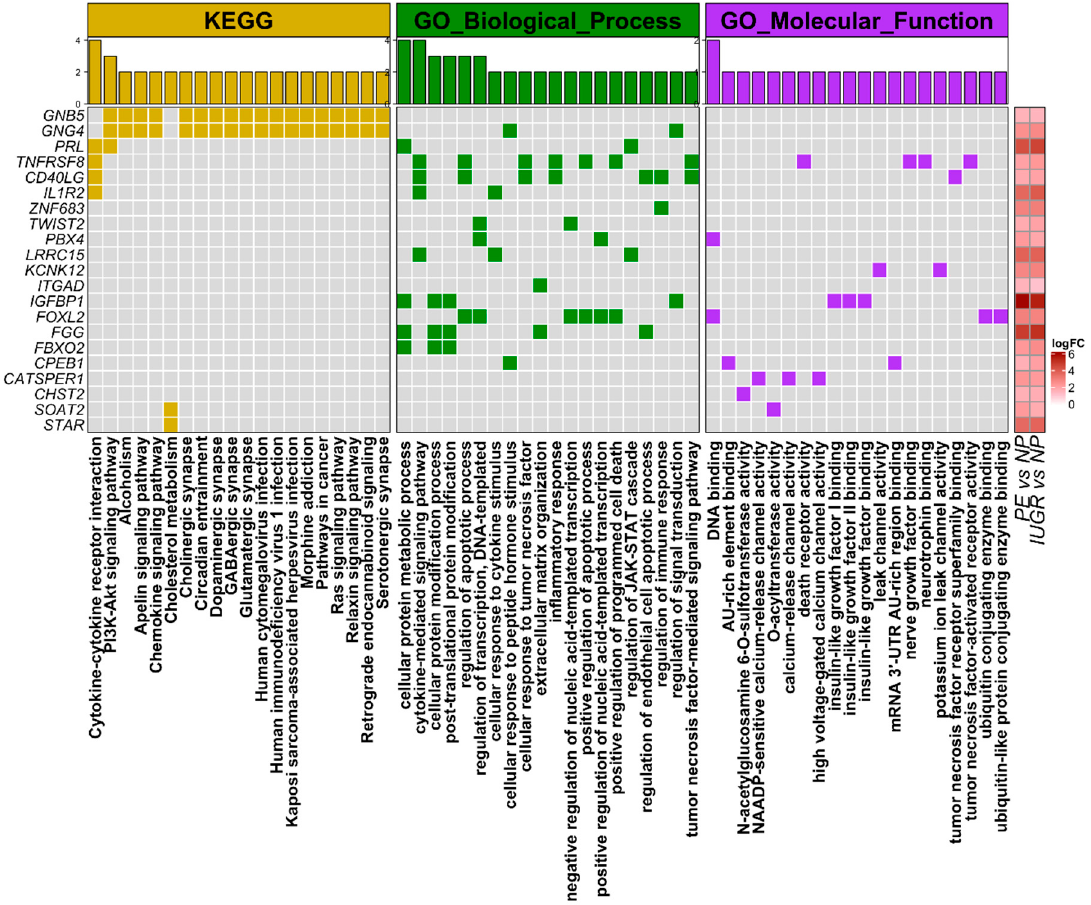
Figure 3. Biological and pathological processed over-represented in 39 differentially expressed genes. In the central panel, matrix shows the genes that are part of the list over-represented terms from KEGG, GO_Biological_processes, and GO_molecular function annotations. Bar plot on the top panel shows the total number of selected genes for each biological term. On the right, matrix shows the level of log2-base expression change (log2 fold-change) for each of the selected differentially expressed genes in the indicated contrast.